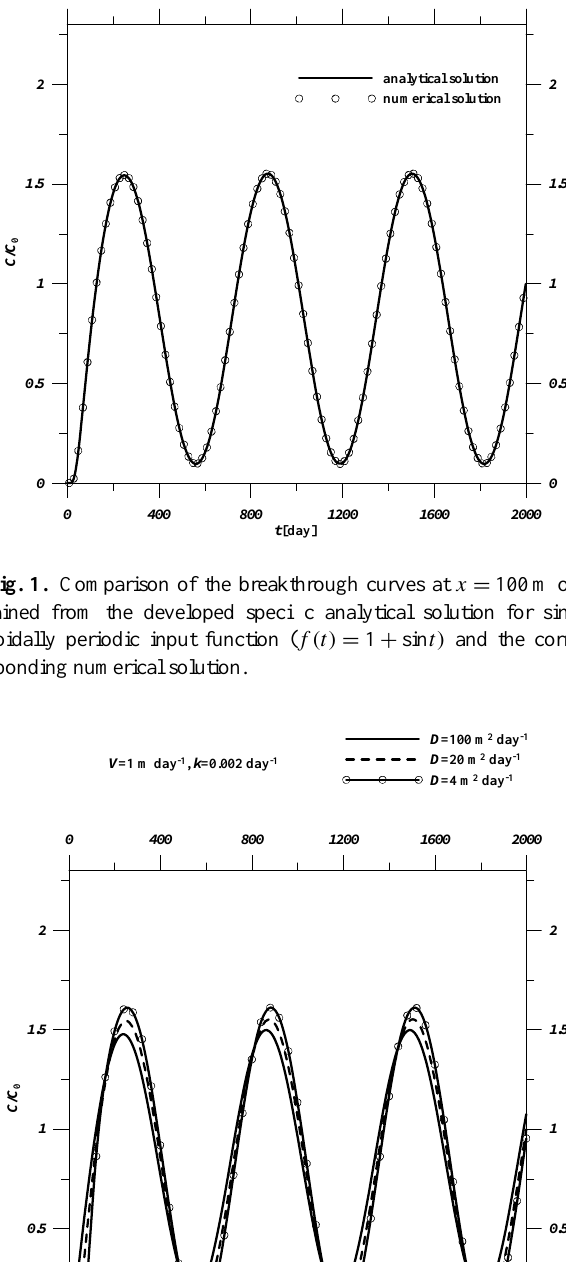
Table 2. Descriptive simulation conditions and transport parame- ters.